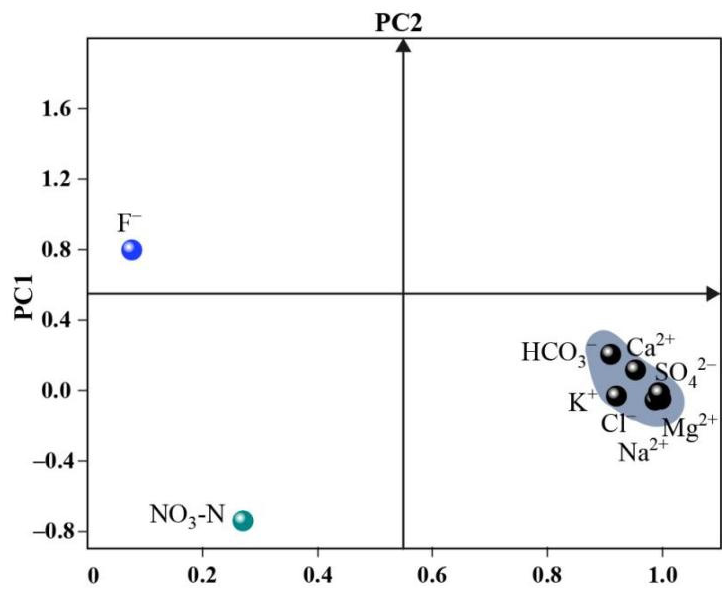
Figure 4. The principal component analysis of major ions in Xiaojiang River. Table 2. Results of PCA